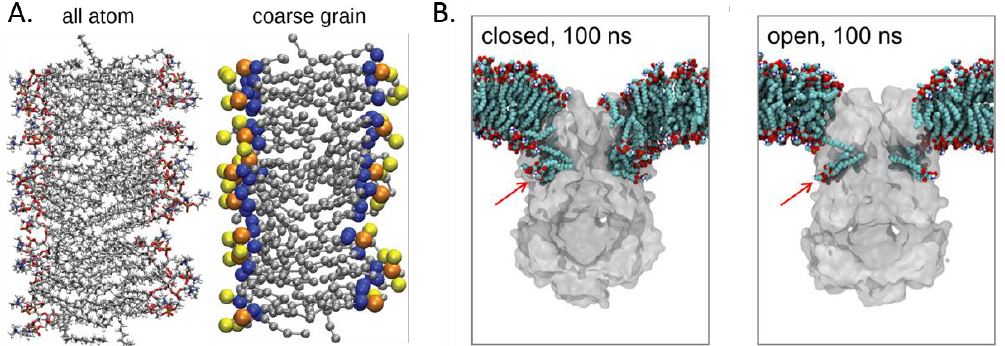
Figure 4. Molecular dynamic (MD) simulations. ( A ) A 1-palmitoyl-2-oleoyl-sn-glycero-3-PC (POPC) bilayer represented in an all-atom model ( left ) vs. a Coarse-grained (CG) model ( right ). Reproduced from [76]. ( B ) Prokaryotic mechanosensitive channel of small conductance (MSCS)–lipid interactions upon closed ( left ) and open ( right ) conformations in CG MD simulations. The red arrow shows the lipid-binding cavity whose occupancy changes between the closed and the open conformation. Original MD simulation from [77].